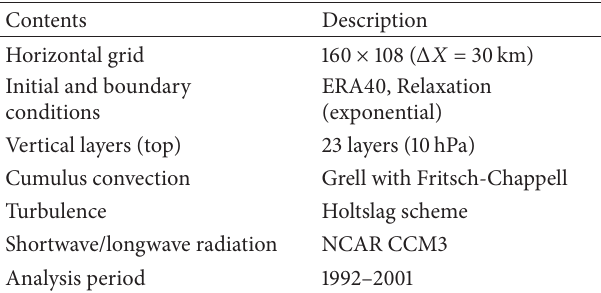
precipitation over the TP during